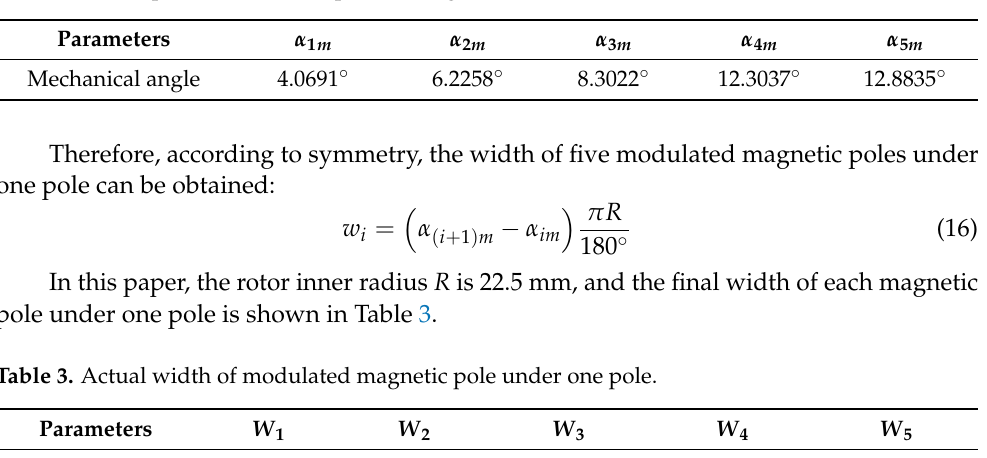
Table 2. Actual parameters of PM position angle.